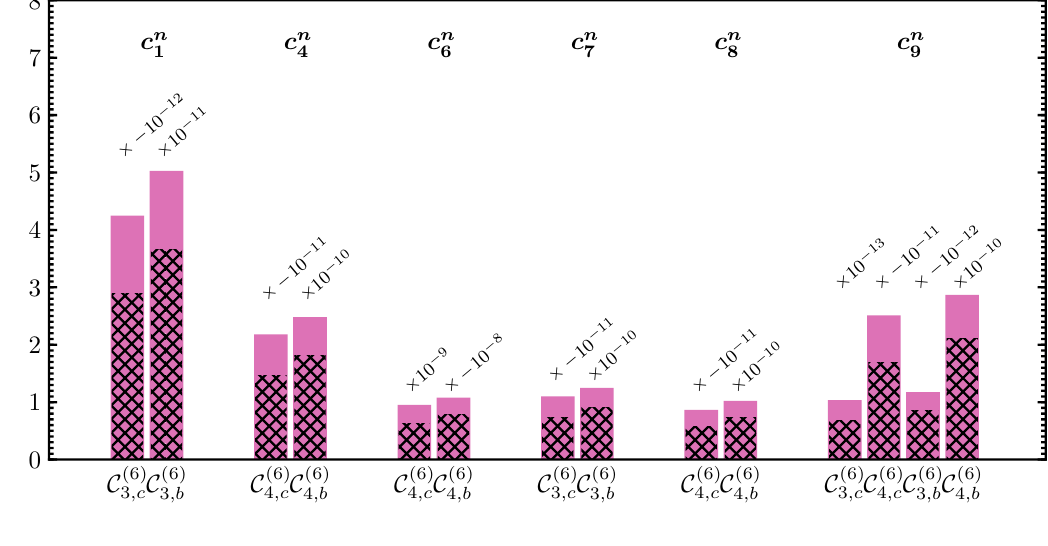
Figure 5 . The same as in (cid:12)gure 4 but for DM couplings to neutrons, c n